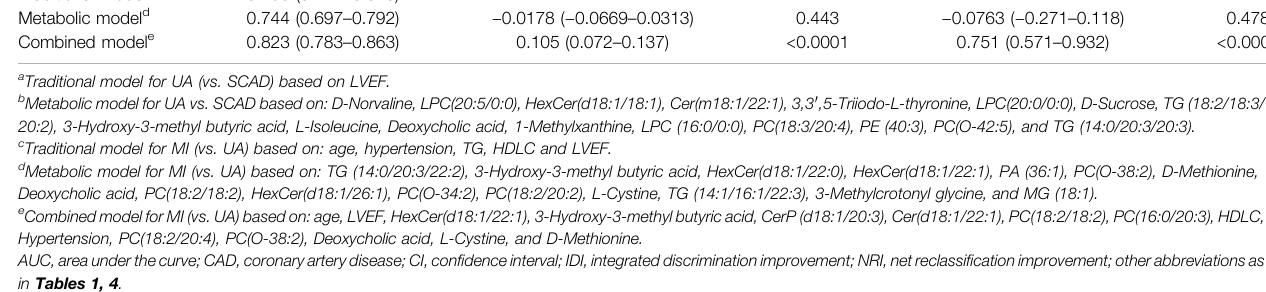
Prediction of UA (vs.